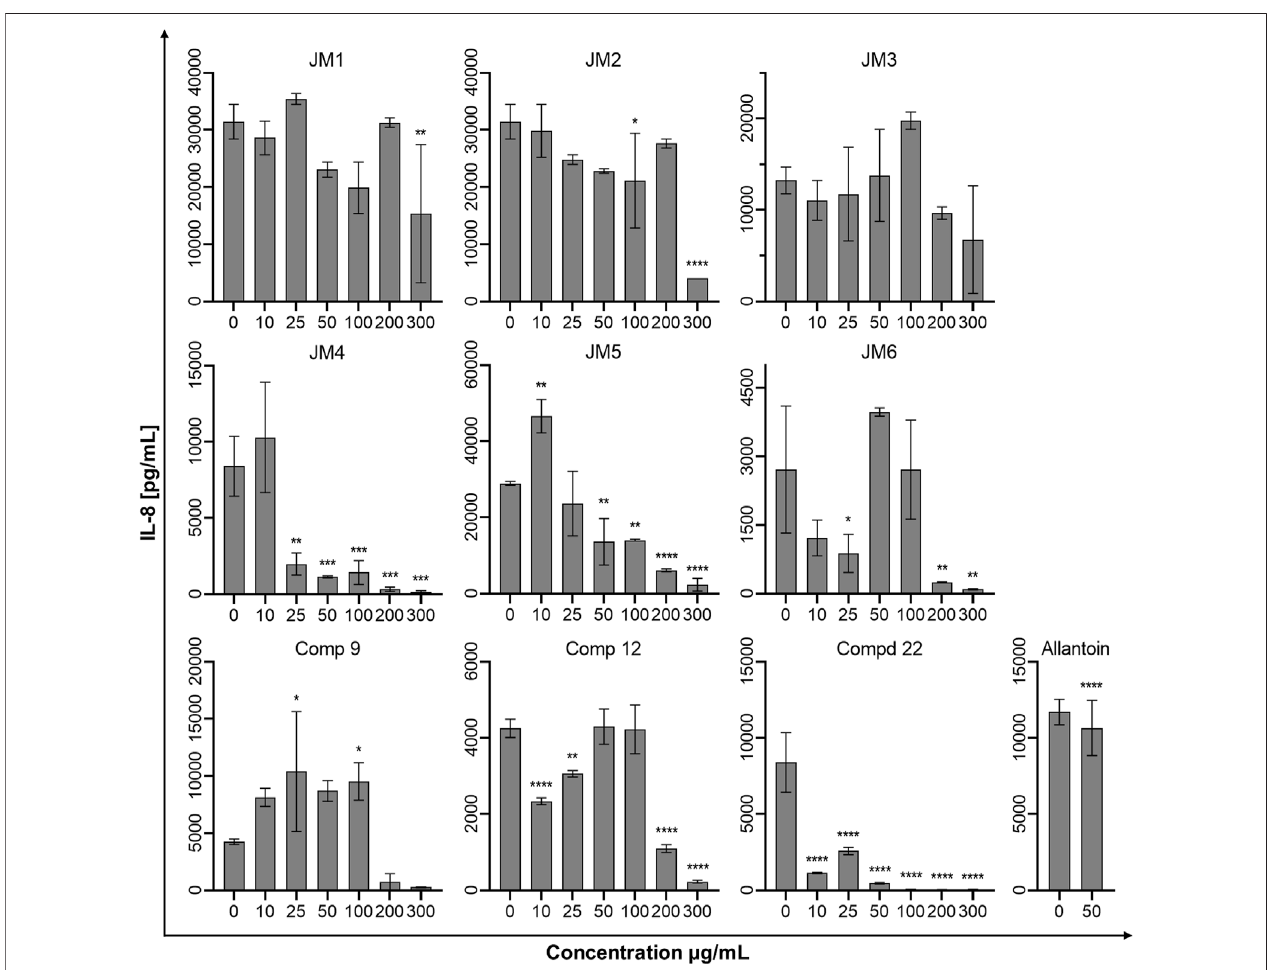
FIGURE 5 | Effects of the J. montana extracts JM1 – JM6 and their main components ( 9 , 12 , and 22 ) (10 – 300 μ g/mL) and allantoin (50 μ g/mL) on IL-8 production inhibition.Meanvaluesfromthreeindependentexperiments( n =3)performedinduplicatearepresented.* p < 0.05versusthecontrolgroup,** p < 0.01versusthecontrol group, *** p < 0.001 versus the control group, **** p < 0.0001 versus the control